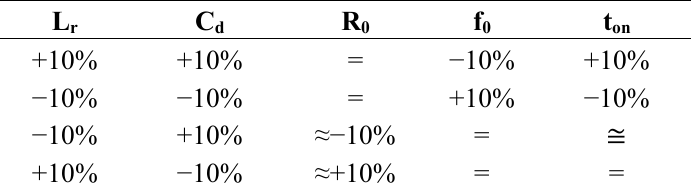
Table 1. Effect of variation of resonant elements on resonant